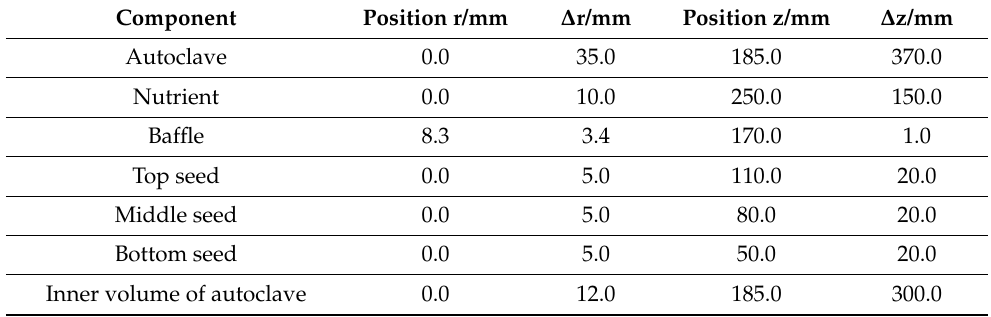
Table 1. Geometry of the model: Components, radial, and vertical positions referring to the center of each component, and radial width as well as vertical height of the components. For the seeds, the thickness refers to the model version with the thicker seeds.